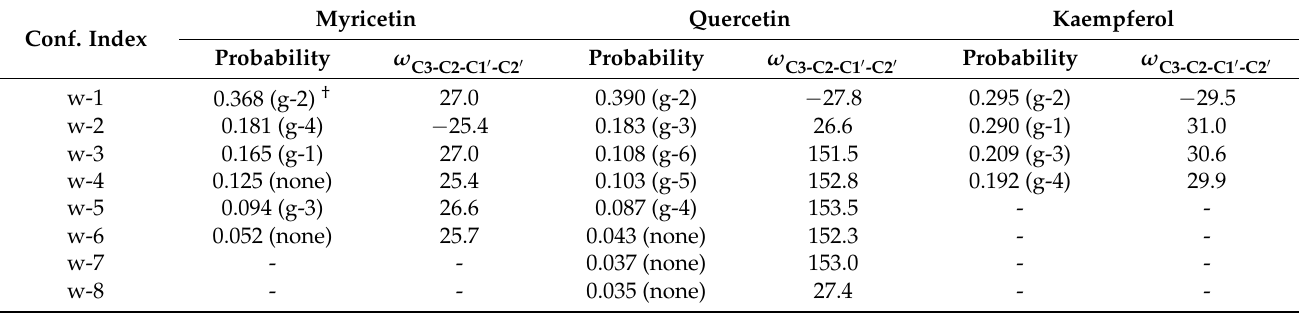
Table 3. The relative population (probability) and dihedral angles of C3-C2-C1 (cid:48) -C2 (cid:48) after the geometry optimization using DFT for each conformer. Values of ω C3-C2-C1 (cid:48) -C2 (cid:48) are shown in